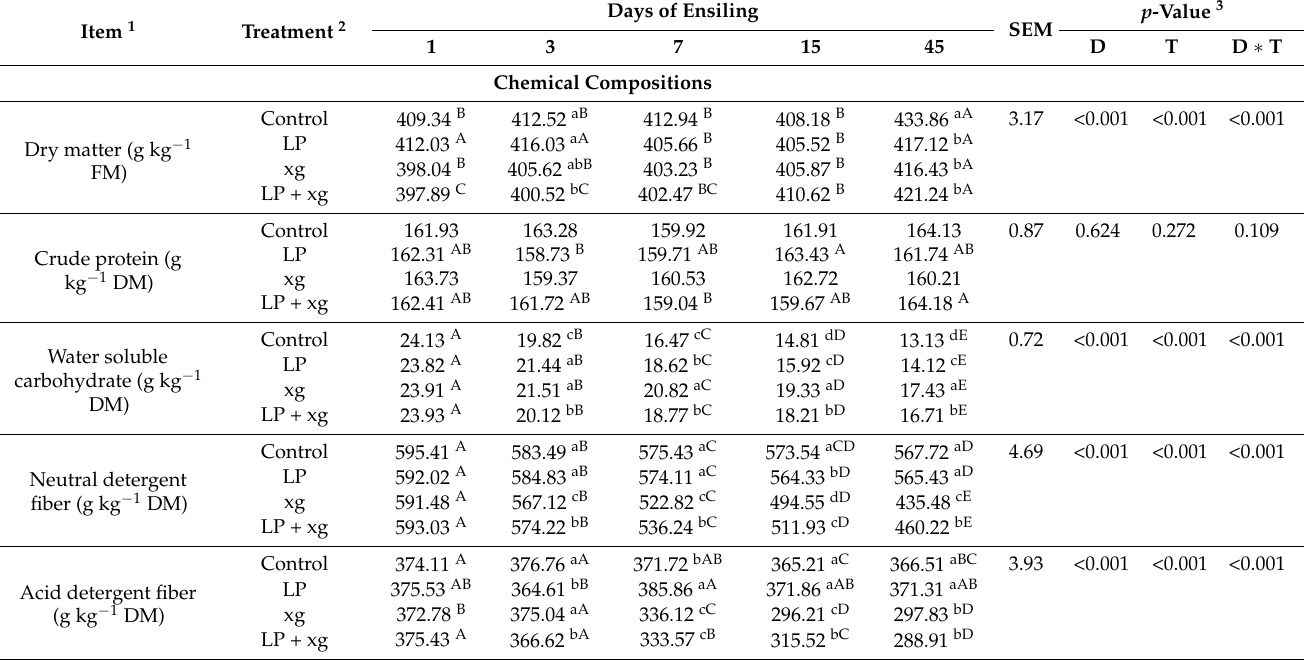
Table 6. Changes in chemical compositions during the ensiling of low-moisture content Stylosanthes